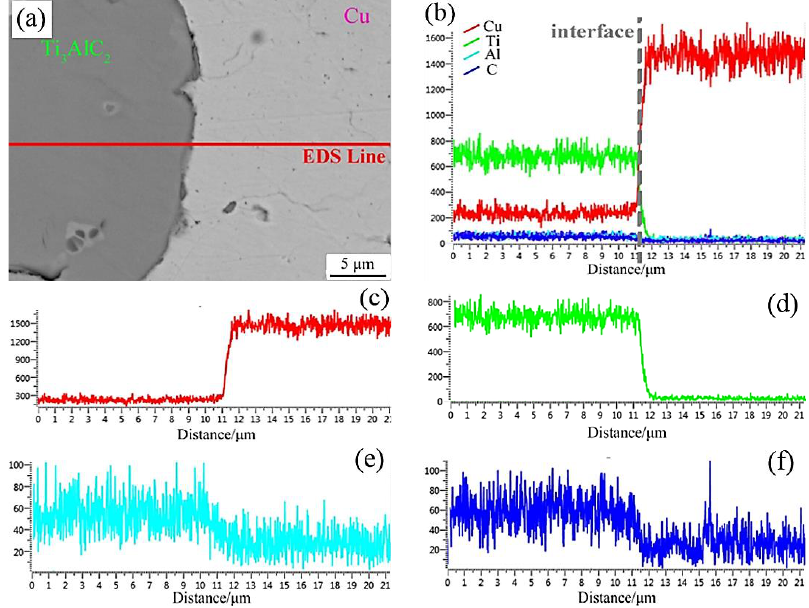
Figure 11. EDS lining of Ti 3 AlC 2 /Cu composites when the volume fraction of Ti 3 AlC 2 is 10 vol.%: ( a ) interface between the Cu matrix and Ti 3 AlC 2 , ( b ) scanning results of all elements, ( c ) Cu elements, ( d ) Ti elements, ( e ) Al elements, ( f ) C elements.